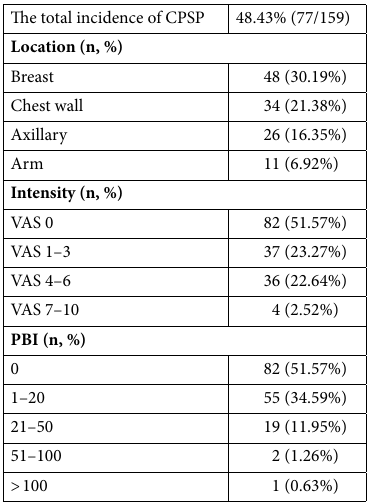
Table 2. The incidence of CPSP, the amount of pain originating from different locations, and the different PBI levels and VAS scores. CPSP chronic post-surgical pain, VAS visual analogue scale, PBI Pain Burden Index.